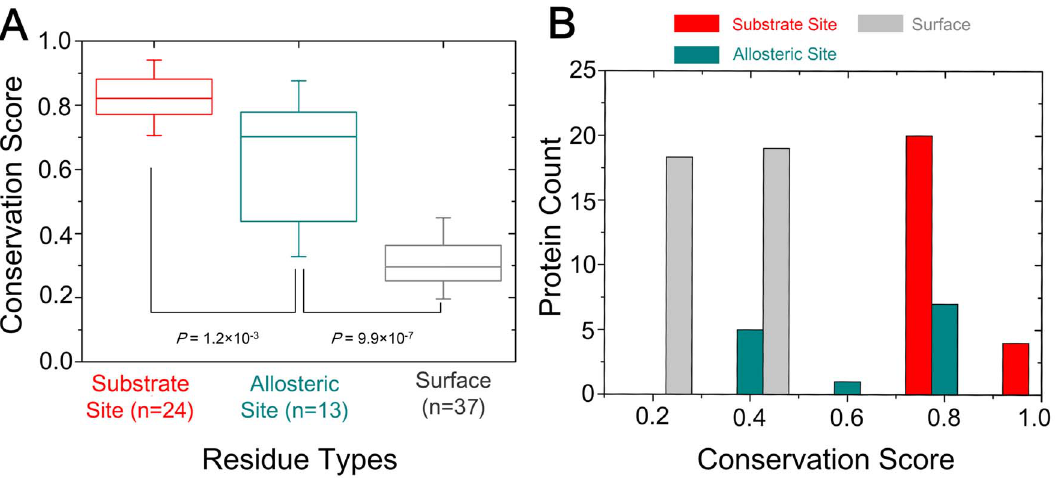
Figure 2. Comparison of evolutionary conservation of allosteric and substrate ATP-binding sites. (A) Distributions of conservation scores for residues in the allosteric and substrate ATP-binding sites as well as in the surface of proteins. (B) Distributions of average conservation scores for residues in the substrate and allosteric ATP-binding sites and the surface per protein. The statistical significant ( P -value) was calculated by the Mann-Whitney U